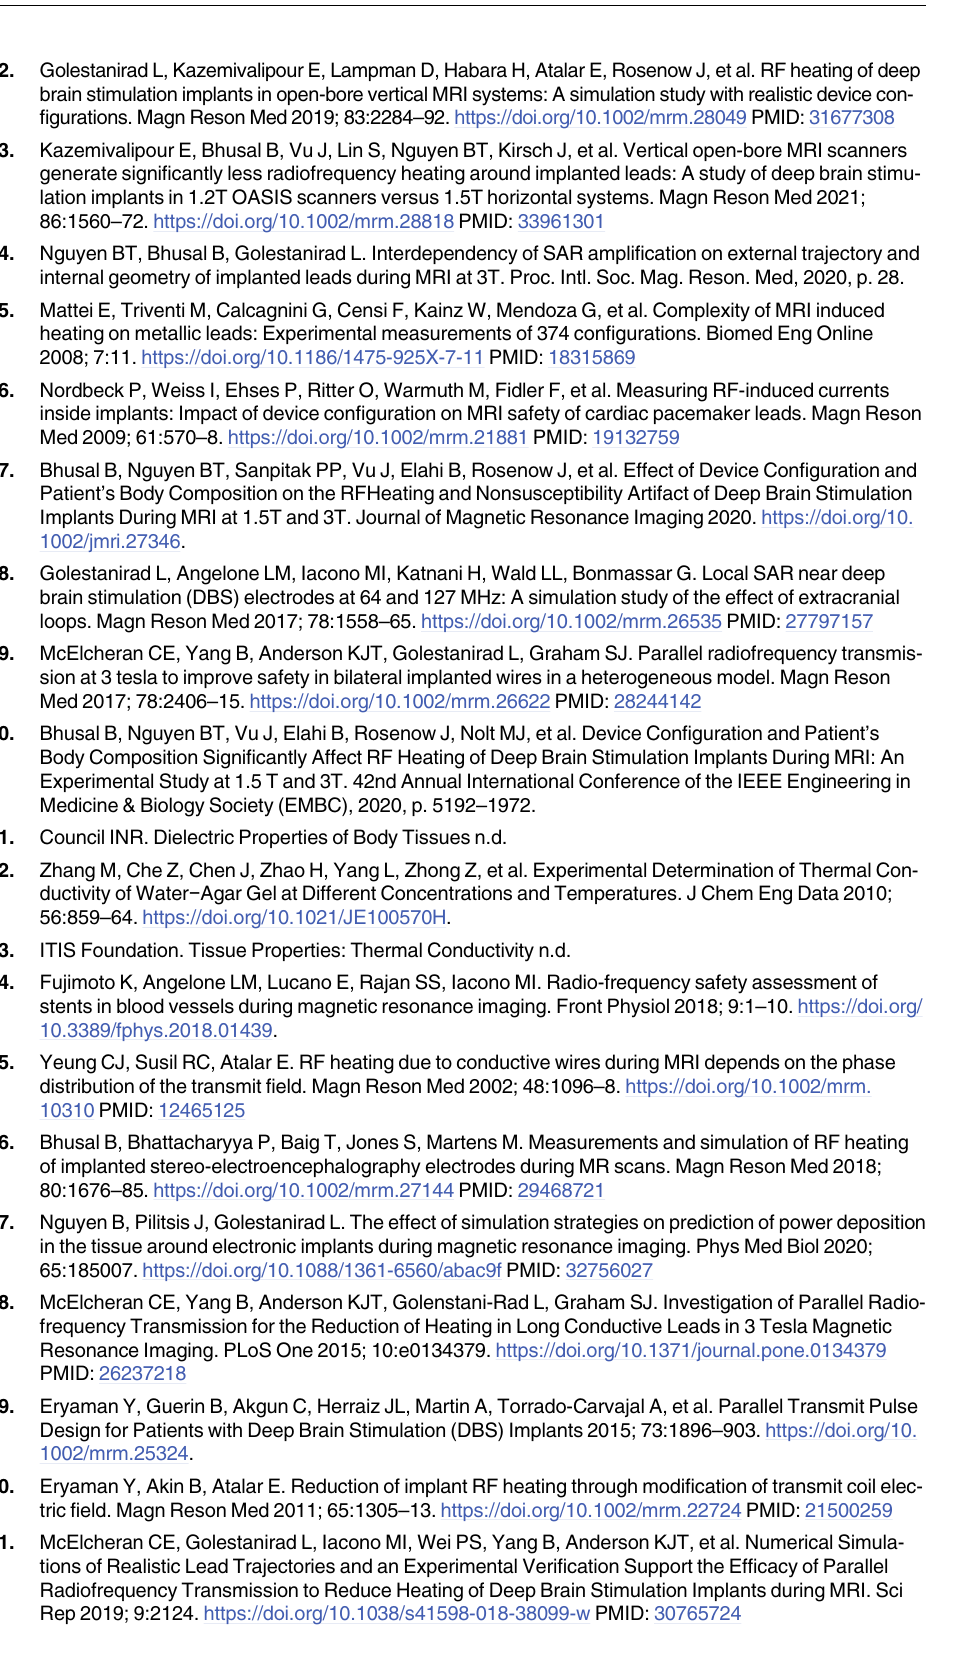
figurations. MagnResonMed 2019;83:2284–92. https://doi.org/10.1002/mrm.28049 PMID: